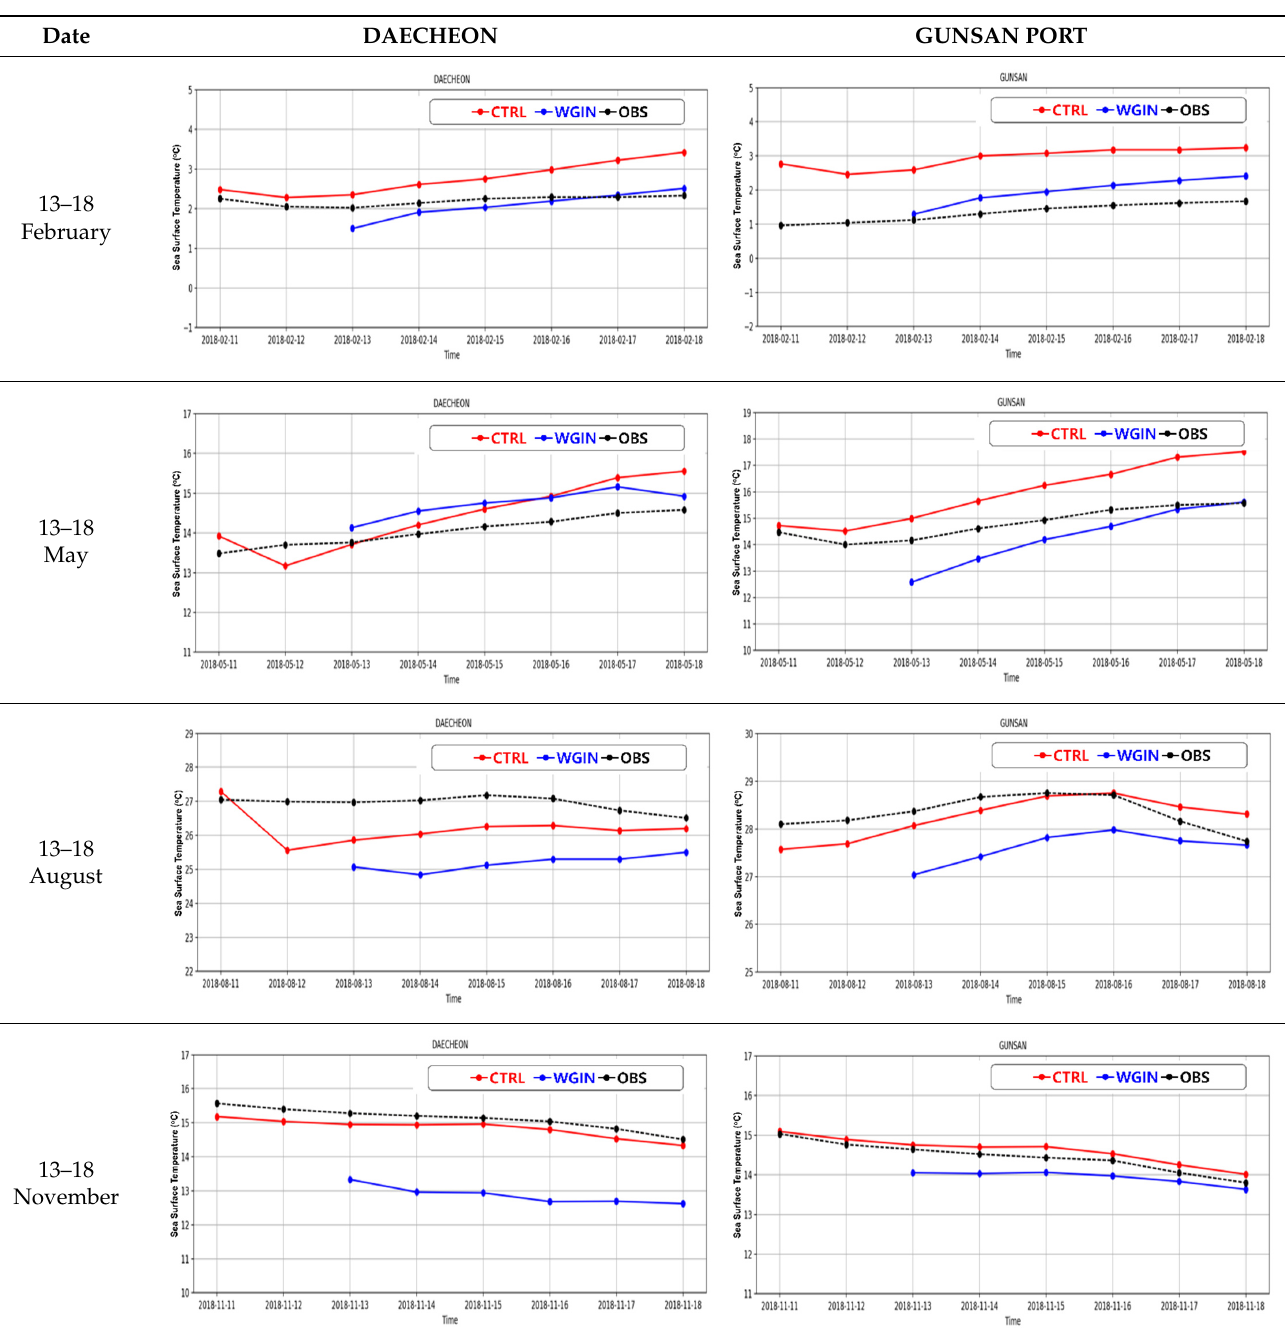
Table 6. Same as Table 4, except for Daecheon (left) and Gunsan Port (right).